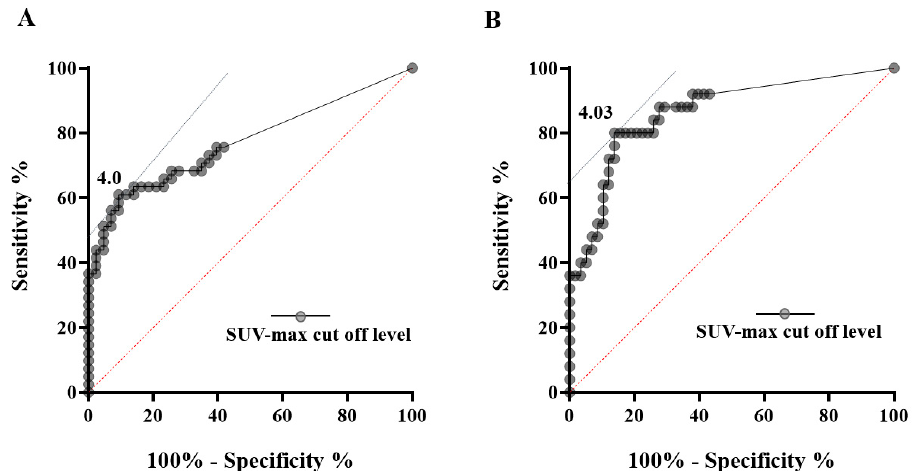
Figure 3. ROC curves. ( A ) Data on the curve represent SUV-max cutoff levels of 4.0 for the differential diagnosis of benign and malignant IPMNs according to the SUV-max of FDG-PET. ( B ) Data on the curve represent SUV-max cutoff levels of 4.03 for the differential diagnosis of low-grade dysplasia/high-grade dysplasia and invasive carcinoma according to the SUV-max of FDG-PET. ROC: receiver operating characteristic. SUV-max: maximum standardized uptake value; FDG-PET: 2- 18 F fluoro-2-deoxy-D-glucose positron emission tomography.